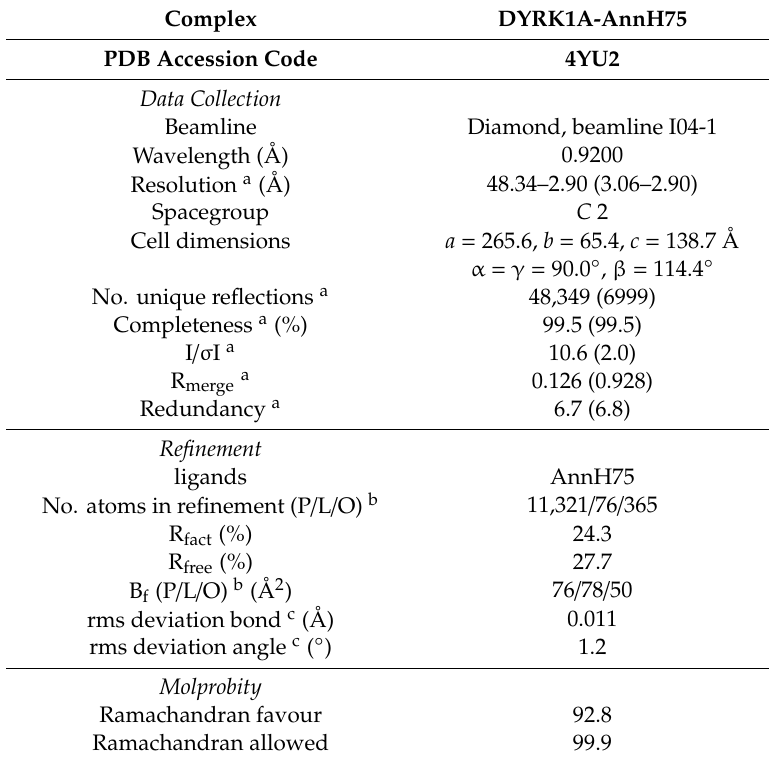
Table 3. Crystal structure data of the DYRK1A- AnnH75 complex (PDB